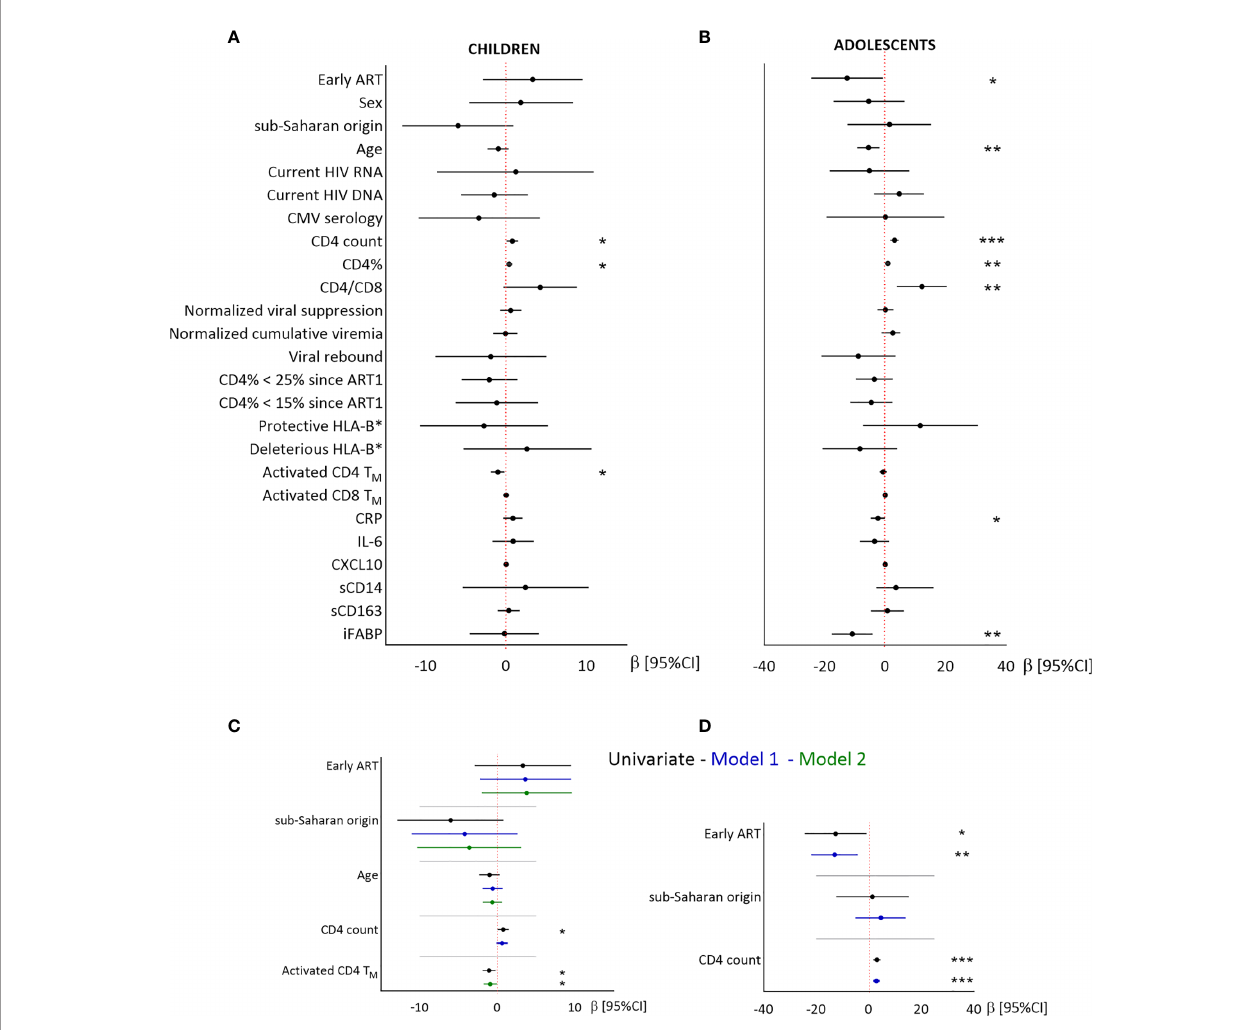
FIGURE 2 | Linear regression analysis of the associations between CD4T N and demographic, virological and immunological factors in children and adolescents. Results from univariate (A, B) and multivariate (C, D) linear regressions are presented as estimates ( b ) and 95% con fi dence intervals. Signi fi cant associations are indicated by symbols (* p < .05; ** p < .01; *** p < .001). Multivariate analysis included the covariables indicated on the plot. A and C: children; B and D: adolescents. Estimates are given per year, 100 CD4 T cells, and 1% activated CD4T M